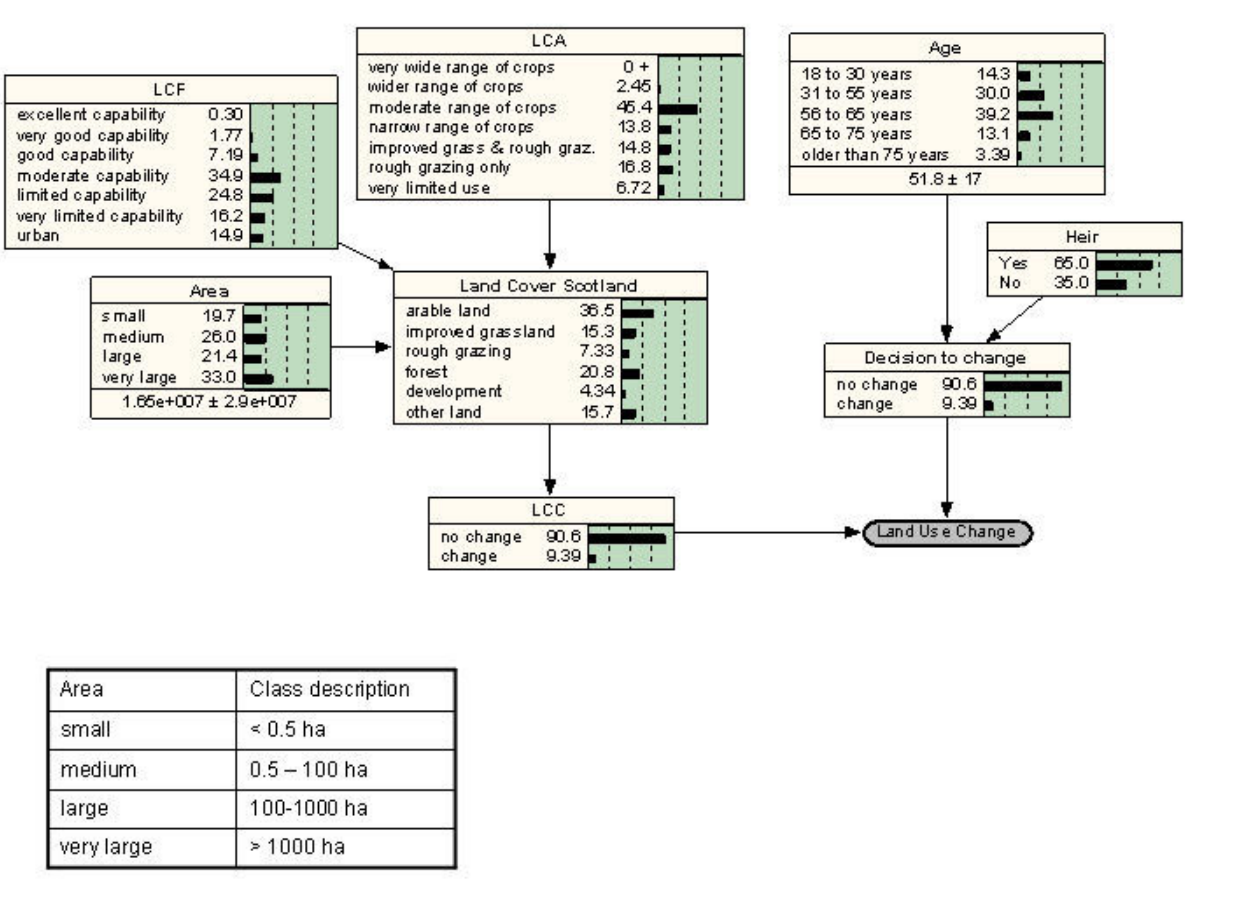
Fig. 3. Model 2 (for the continuous variables, the average and the standard deviation are given below the probability